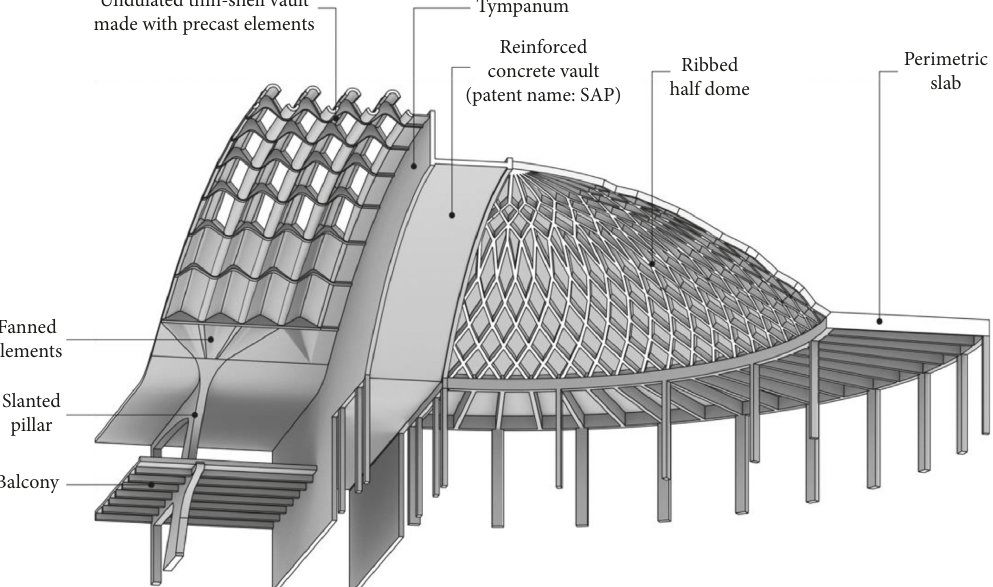
Figure 4: The main structural elements of Hall B. Detail of the joint between the ribbed half-dome and the undulated vault of the hall.